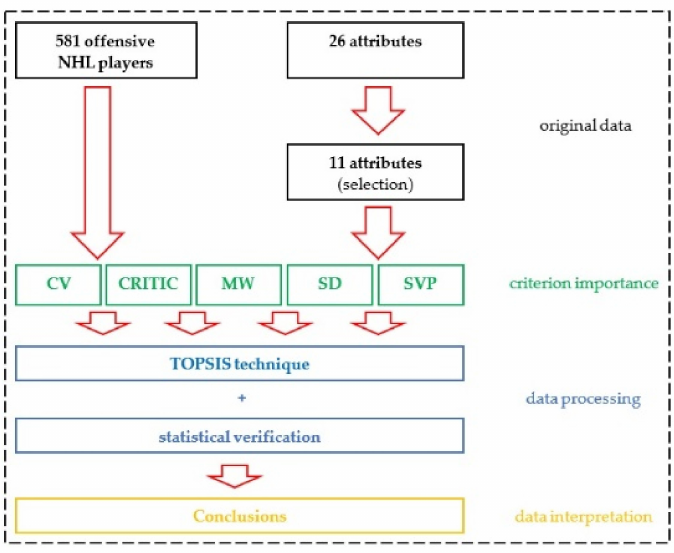
Figure 2. Research methodology algorithm.